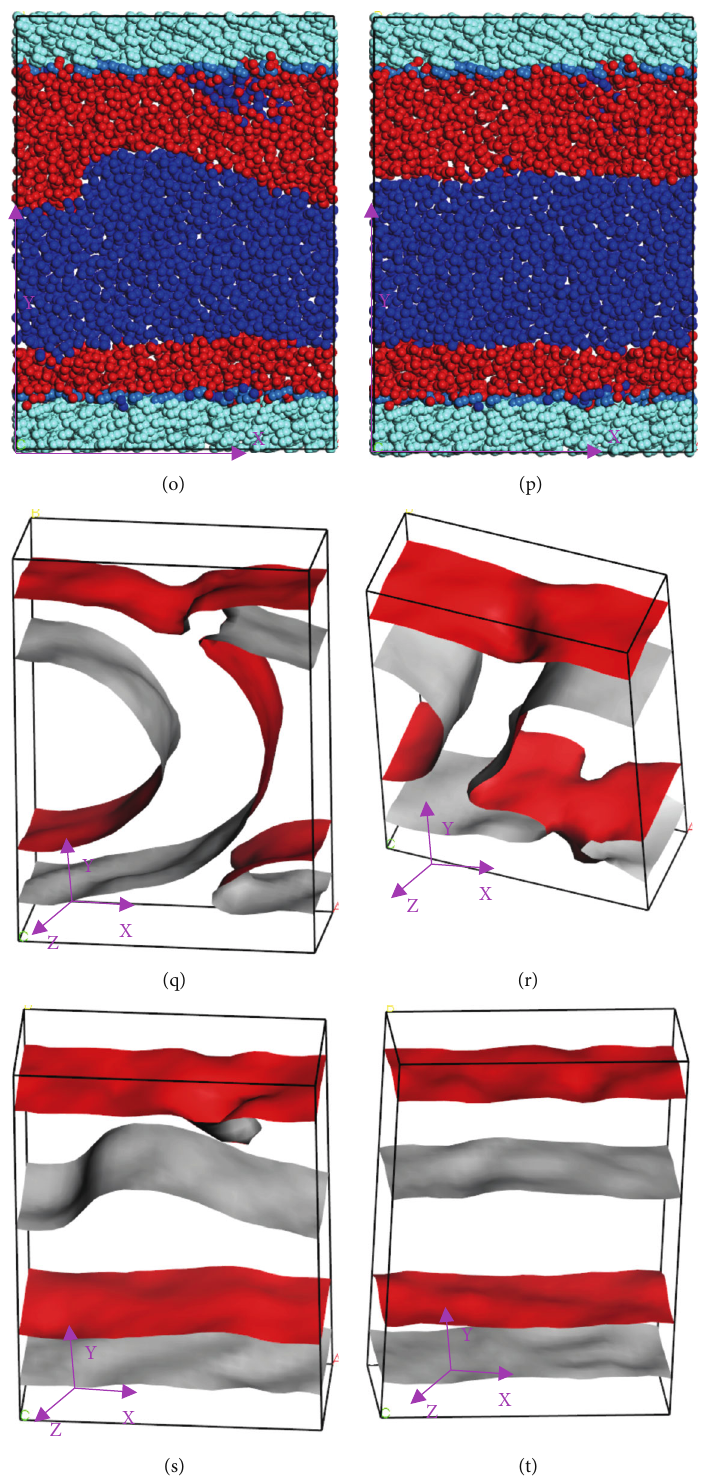
Figure 4: Section of the slits and isodensity pro fi le of water phase; (a) section of model 1 and step 50; (b – e) section of model 2 and steps 7, 14, 17, and 26; (f – h) section of model 4 and steps 11, 27, and 50; (i – l) section of model 4 and steps 3, 13, 19, and 24; (m) – p) section of model 4 and steps 5, 8, 11, and 17; (q – t) oil isodensity pro fi le of model 6 and step 4, 8, 11, and